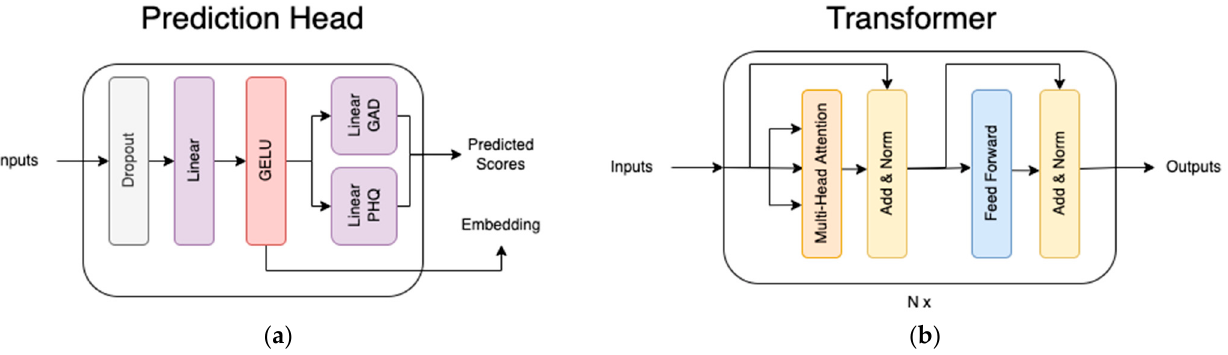
Figure 4. The structure of the two blocks used in the model: (a) The prediction head, which takes Figure 4. Thestructureofthetwoblocksusedinthemodel: ( a )Thepredictionhead,whichtakesembeddings embeddings from upstream models and produces scores; (b) the transformer encoder block de- from upstream models and produces scores; ( b ) the transformer encoder block described in scribed in [9].